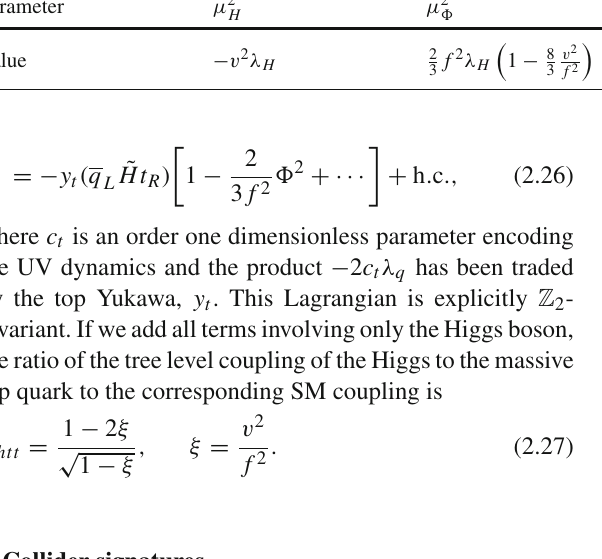
Table 1 Values of the different parameters of the renormalizable scalar potential as a function of f , to order O (v 2 / f 2 ) . v ∼ 246 GeV and λ ∼ 0 . 13 stand for the SM EW VEV and the Higgs quartic coupling, respectively H